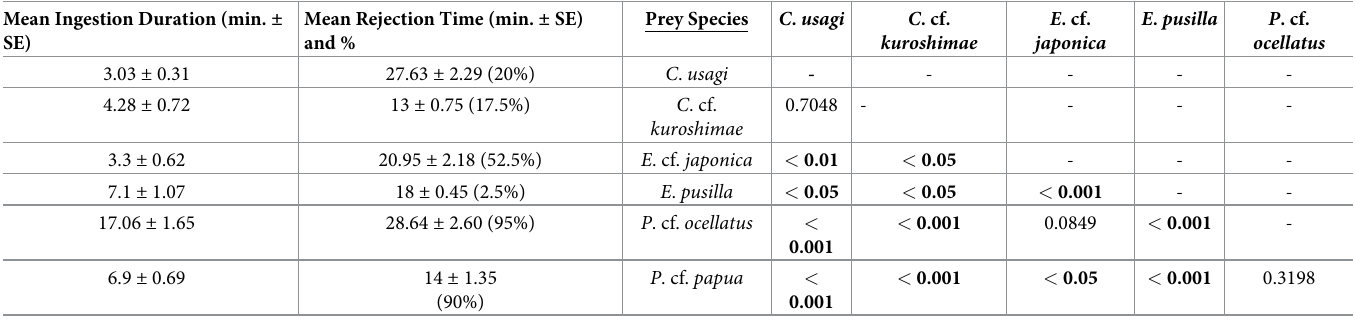
Table 2. On the left, mean duration of ingestion and mean time to rejection per species in minutes and proportion of prey items rejected (including incomplete ingestion) as % of total trials per species. On the right, pairwise Wilcoxon rank sum p values for comparison between prey species for the consumption scores. Significant results were considered as those with p <